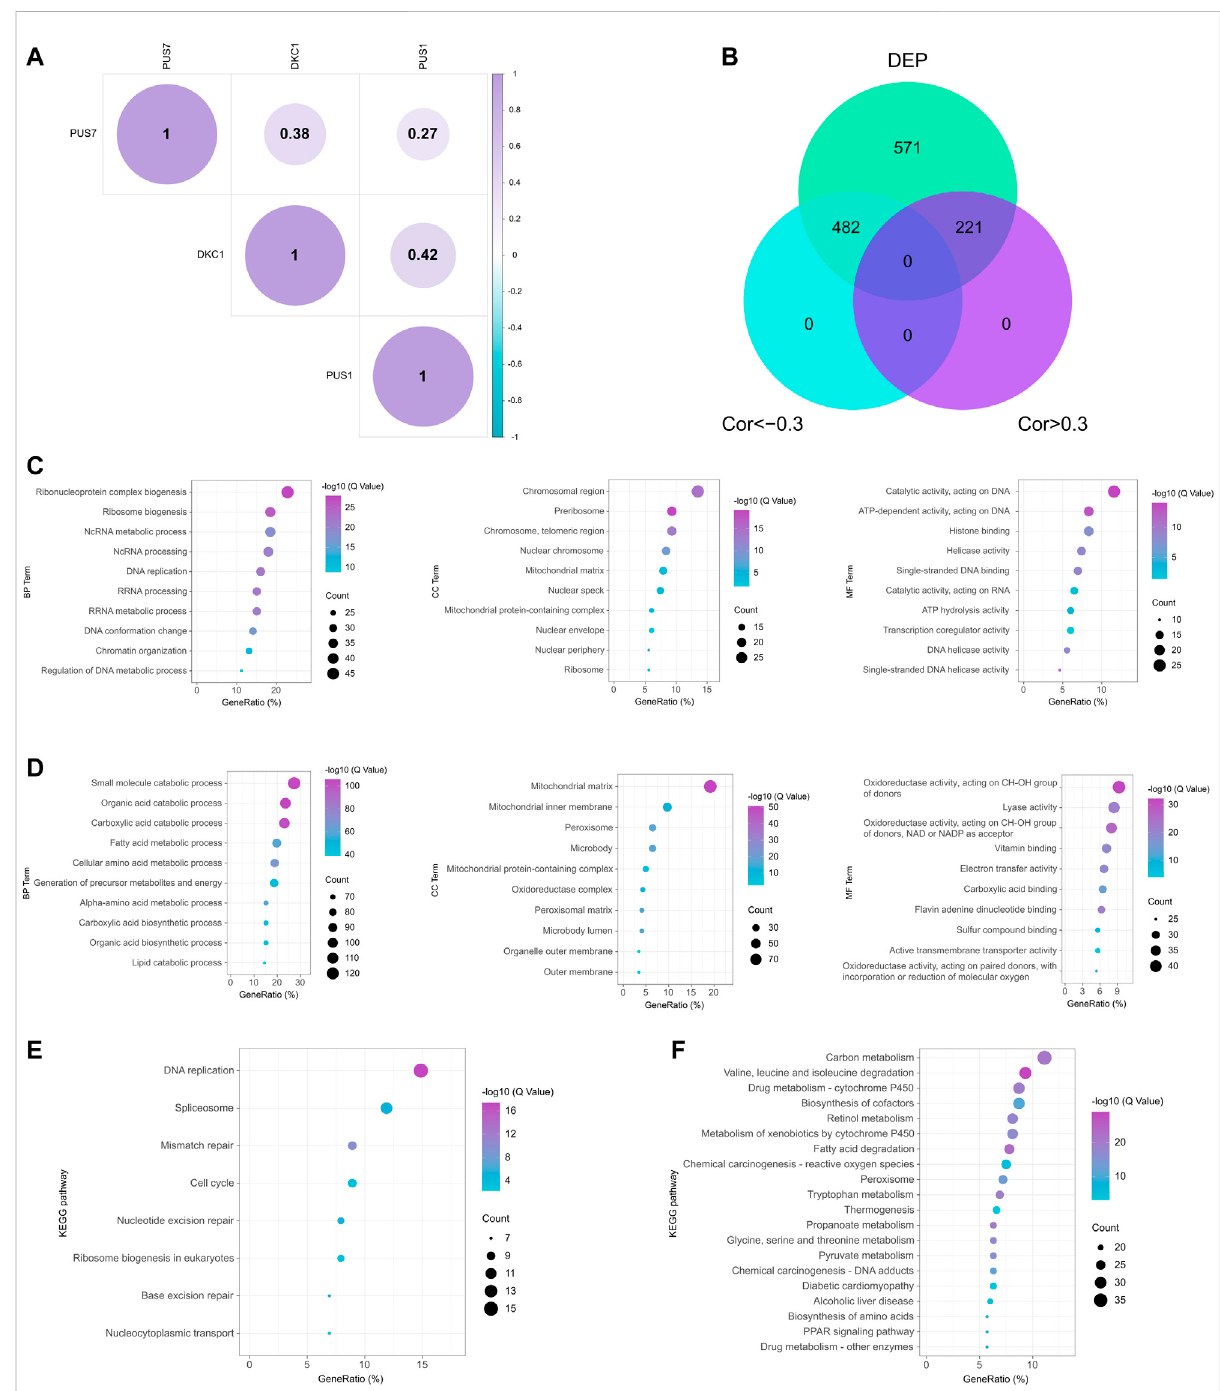
FIGURE 9 Potential functions of PUS proteins in HCC. (A) Correlation of three prognosis-related PUS proteins expression; (B) Venn diagram of DEPs co- expressedwithPUSproteins; (C – D) GOtermsforDEPspositively (C) andnegatively (D) correlatedwithPUSproteins; (E – F) KEGGpathwaysforDEPs positively (E) and negatively (F) correlated with PUS